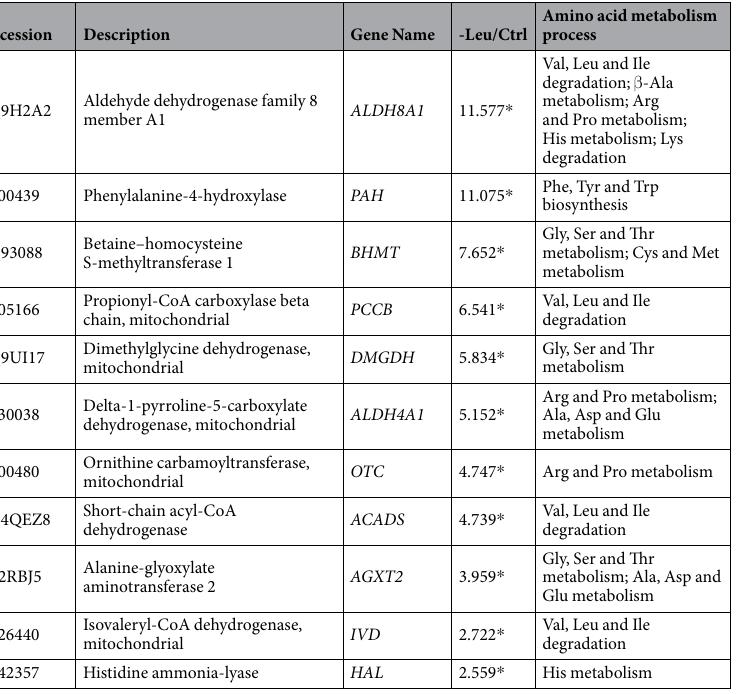
Table 2. All the amino acid metabolism-related differentially expressed proteins. * P < 0.05. Val, valine; Leu, leucine; Ile, isoleucine; Ala, alanine; Arg, arginine; Pro, proline; His, histidine; Lys, lysine; Phe, phenylalanine; Tyr, tyrosine; Trp, tryptophan; Gly, glycine; Ser, serine; Thr, threonine; Cys, cysteine; Met, methionine; Asp, aspartate; Glu,